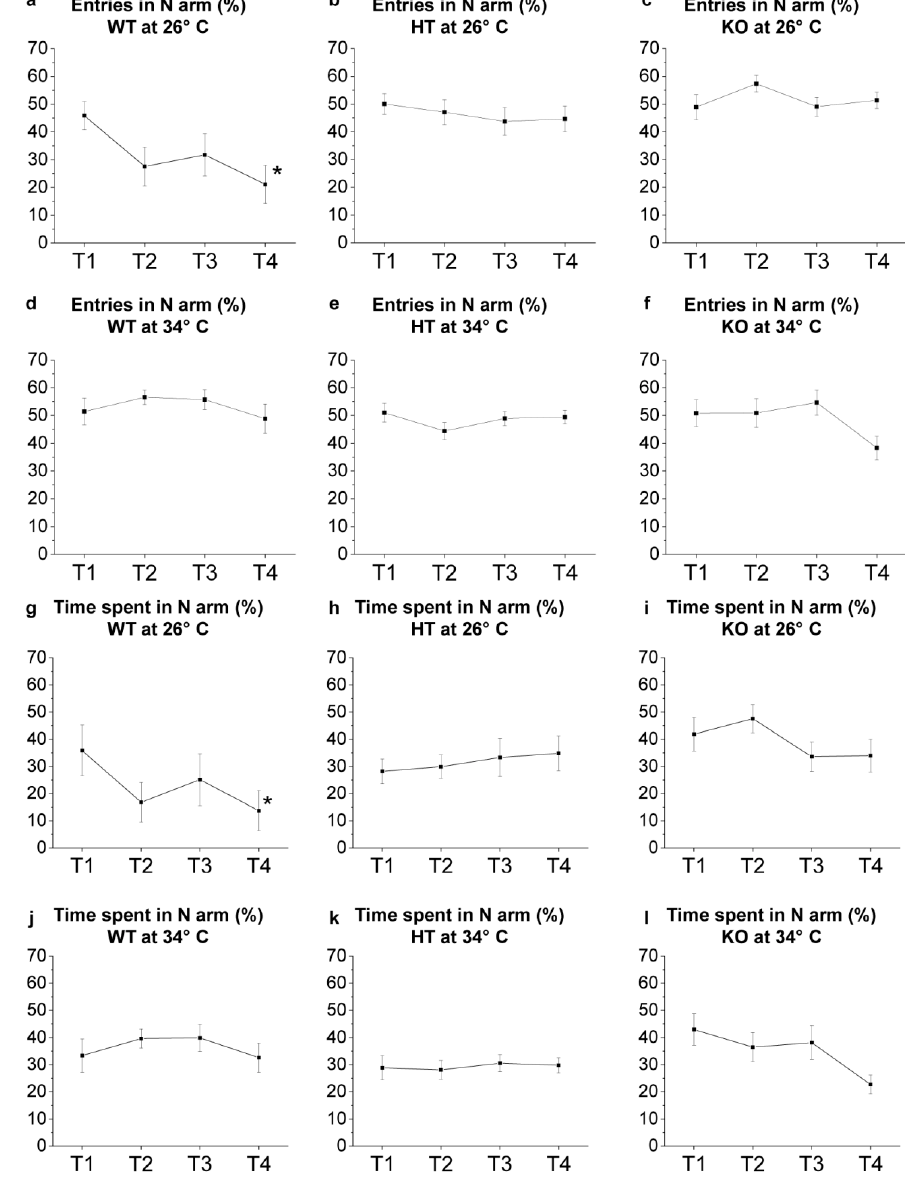
Figure 9. YMT: novel environment exploration T1–T4. ( a – f ) Number of entries in N arm expressed as percentage of total entries in Y-maze arms; ( g – l ) time spent in N arm expressed as percentage of total time performed by WT ( a , d , g , j ), HT ( b , e , h , k ) and KO ( c , f , i , l ) at 26 °C ( a – c , g – i ) or 34 °C ( d – f , j – l ). The data were analysed by one-way repeated measures ANOVA with post hoc Bonferroni correction. p ≤ 0.05, *, compared to T1. p values are reported in Table S22. N =